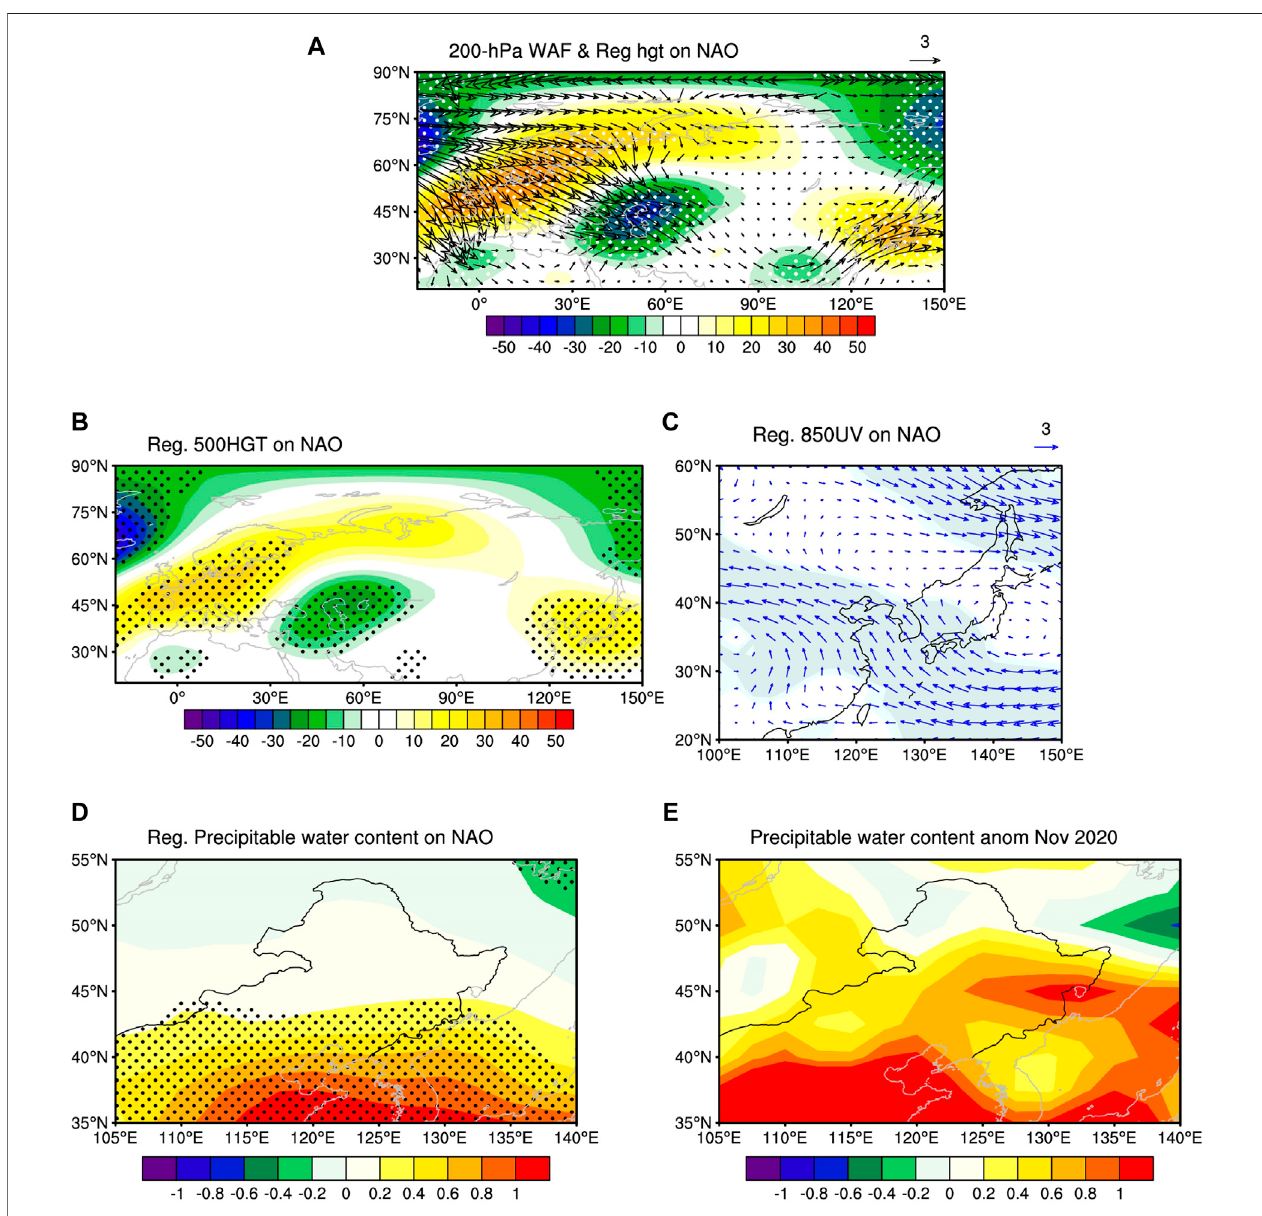
FIGURE 6 | (A) Rossby wave activity fl ux (vectors; unit: m 2 s − 2 ) and regression of 200-hPa HGT (contours; unit: gpm), (B) 500-hPa HGT (unit: gpm), (C) 850-hPa winds (unit: m s − 1 ), and (D) precipitable water (unit: mm) on the NAO-index for November during 1979 – 2019. (E) Anomalous precipitable water in November 2020. Regions above the 90% signi fi cance level are dotted in (A,B,D) and shaded in (C) .